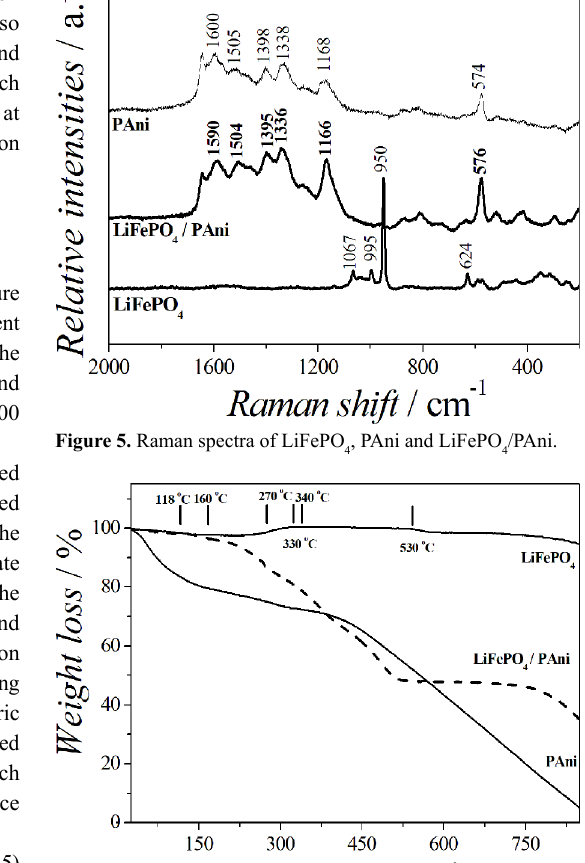
/PAni, in synthetic 4